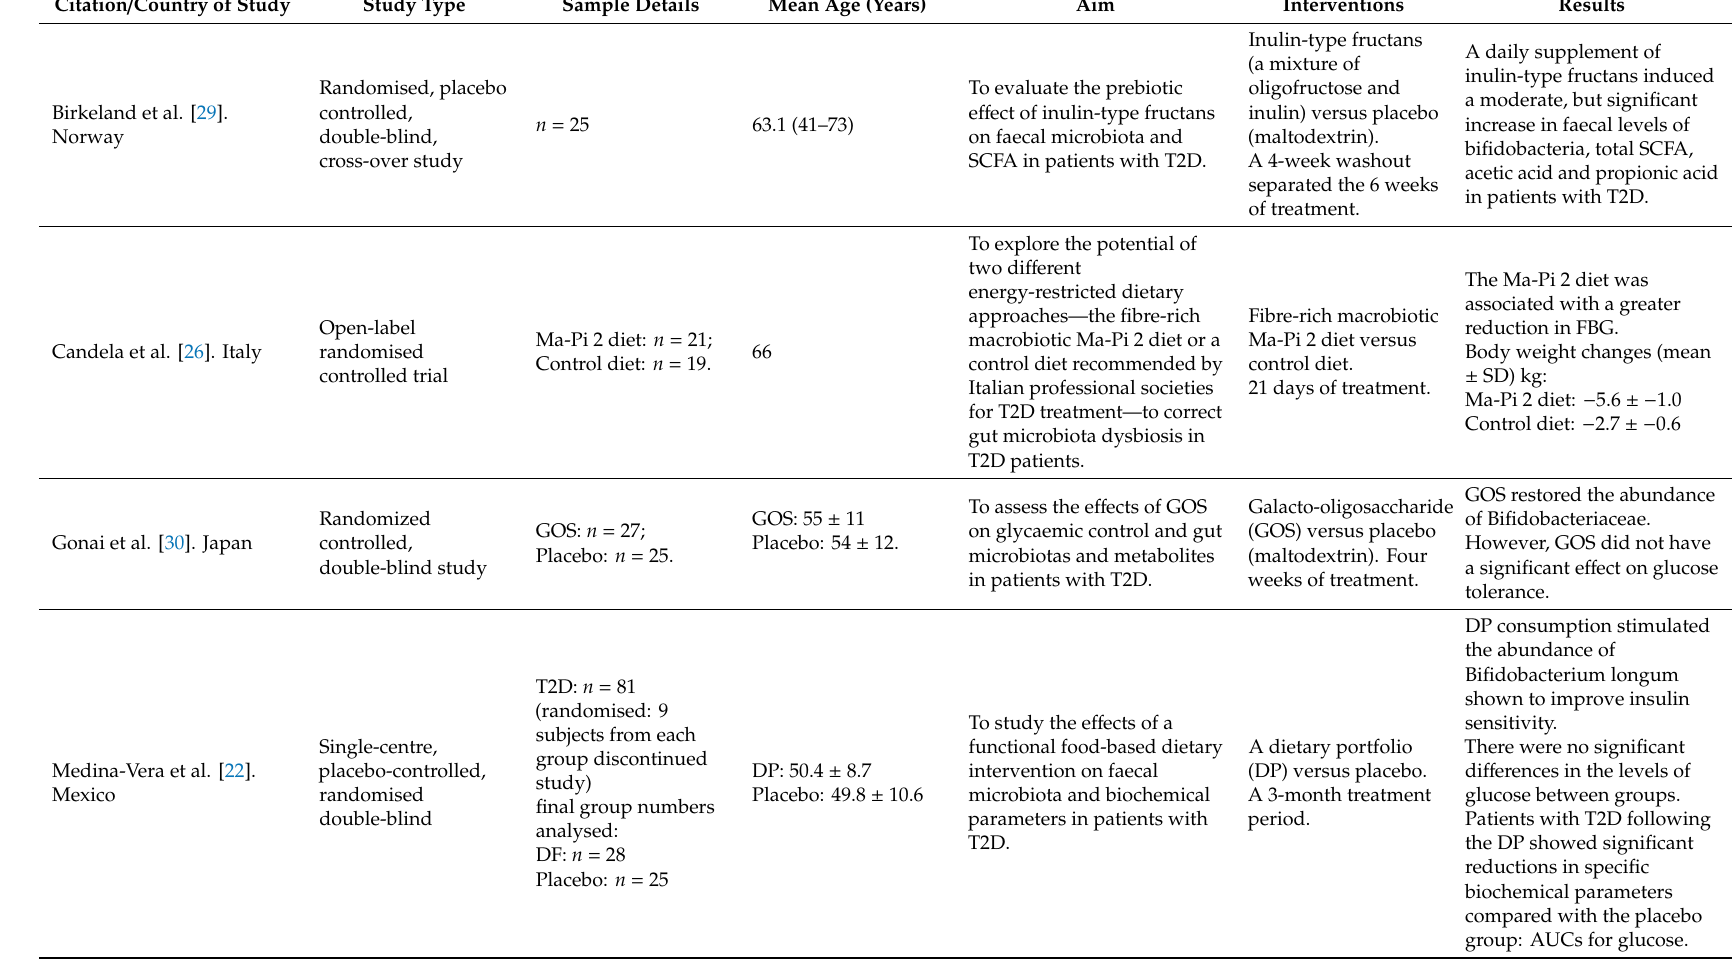
Table 2. The description and characteristics of included